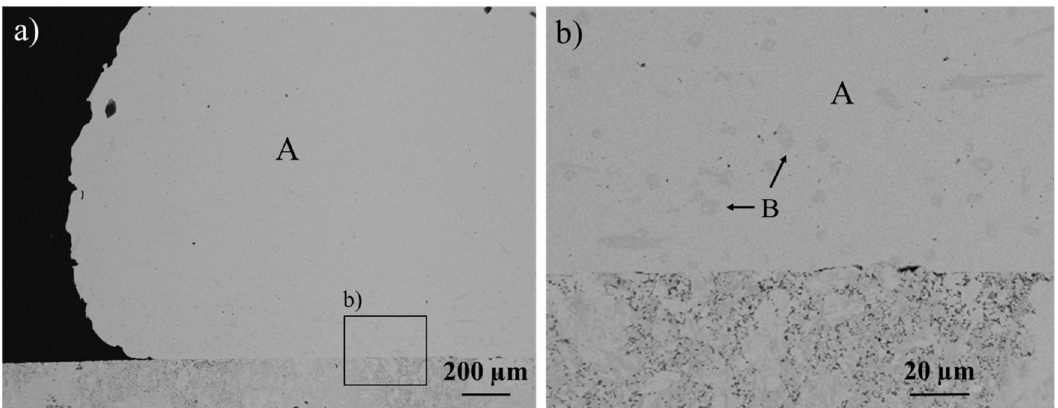
Figure 9. ( a ) SEM-EDS micrograph (BSE) of the cross-section of Fe100_SPS after interaction with pure Sn at 773 K; ( b ) SEM-EDS (BSE) magnification of a selected area indicated by rectangle in ( a ).